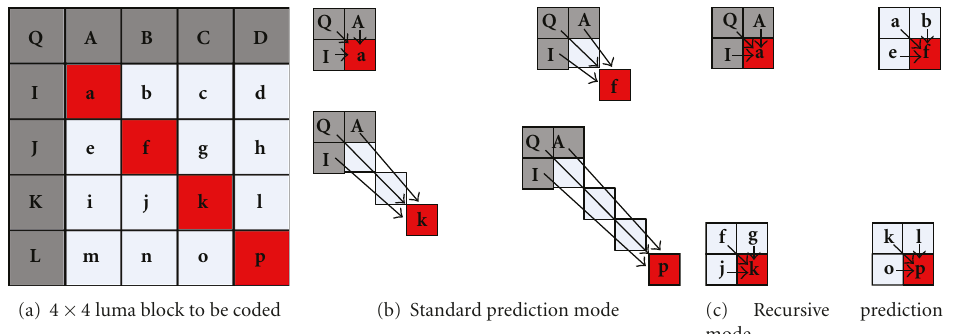
Figure 2: Comparison between recursive prediction mode and standard prediction mode.